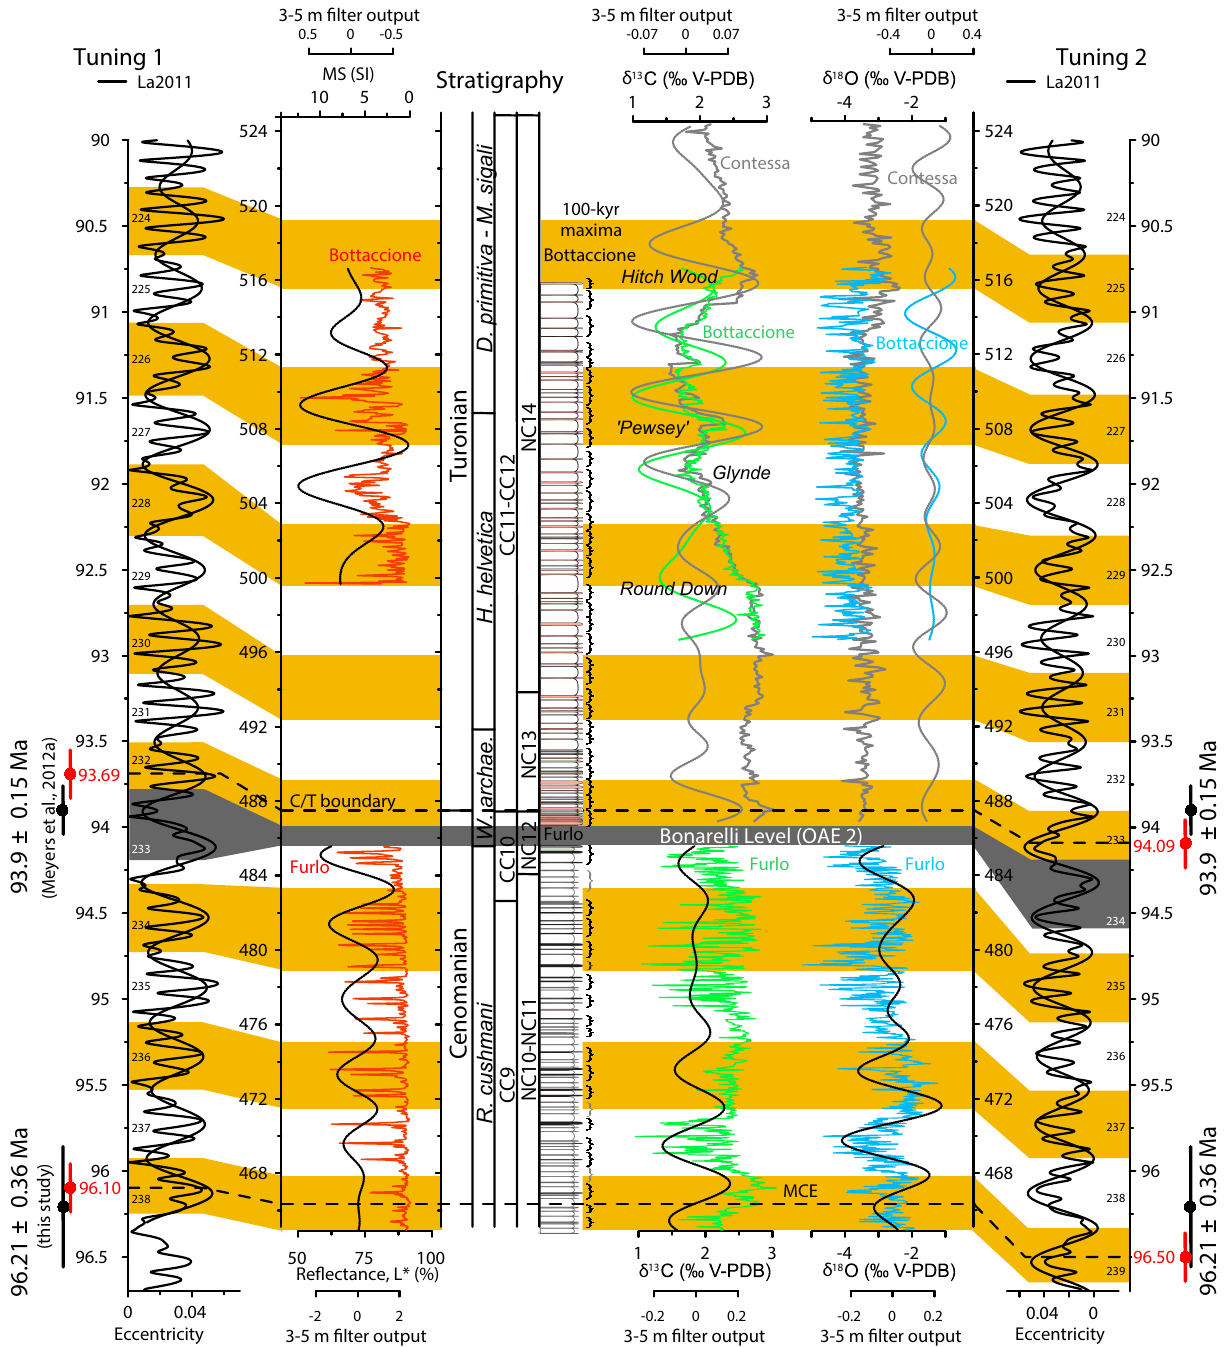
Figure 3. Cyclostratigraphic interpretation of the C/T interval of the Umbria–Marche Basin. Brackets indicate 100kyr bundles of precession- paced lithological alternations, further grouping in 405kyr cycles is indicated by alternating yellow–white bands. Geophysical records ( L ∗ and MS) accentuate the hierarchical stacking pattern. Stable isotope ratios show increased amplitude and a tendency towards more negative values during eccentricity maxima. Isotopic records in grey are from Stoll and Schrag (2000). Event names in italics refer to nomenclature of Jarvis et al. (2006). Astronomical tuning options to La2011 are presented, with 405kyr cycle numbering back from the present day, next to radioisotopic ages discussed in this